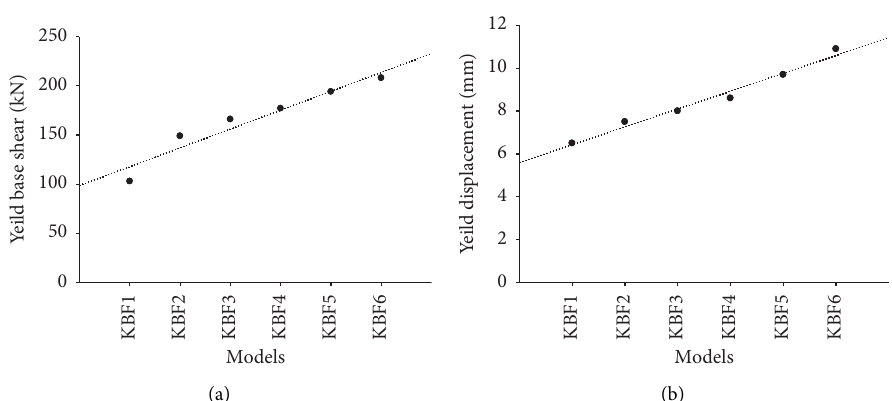
Figure 18: (a) Te model’s yield base shear. (b) Te model’s yield